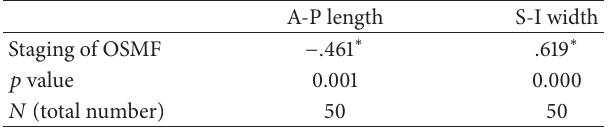
Table 5: Correlation of anteroposterior (A-P) length and superoin- ferior (S-I) width with the staging of OSMF using Spearman rank